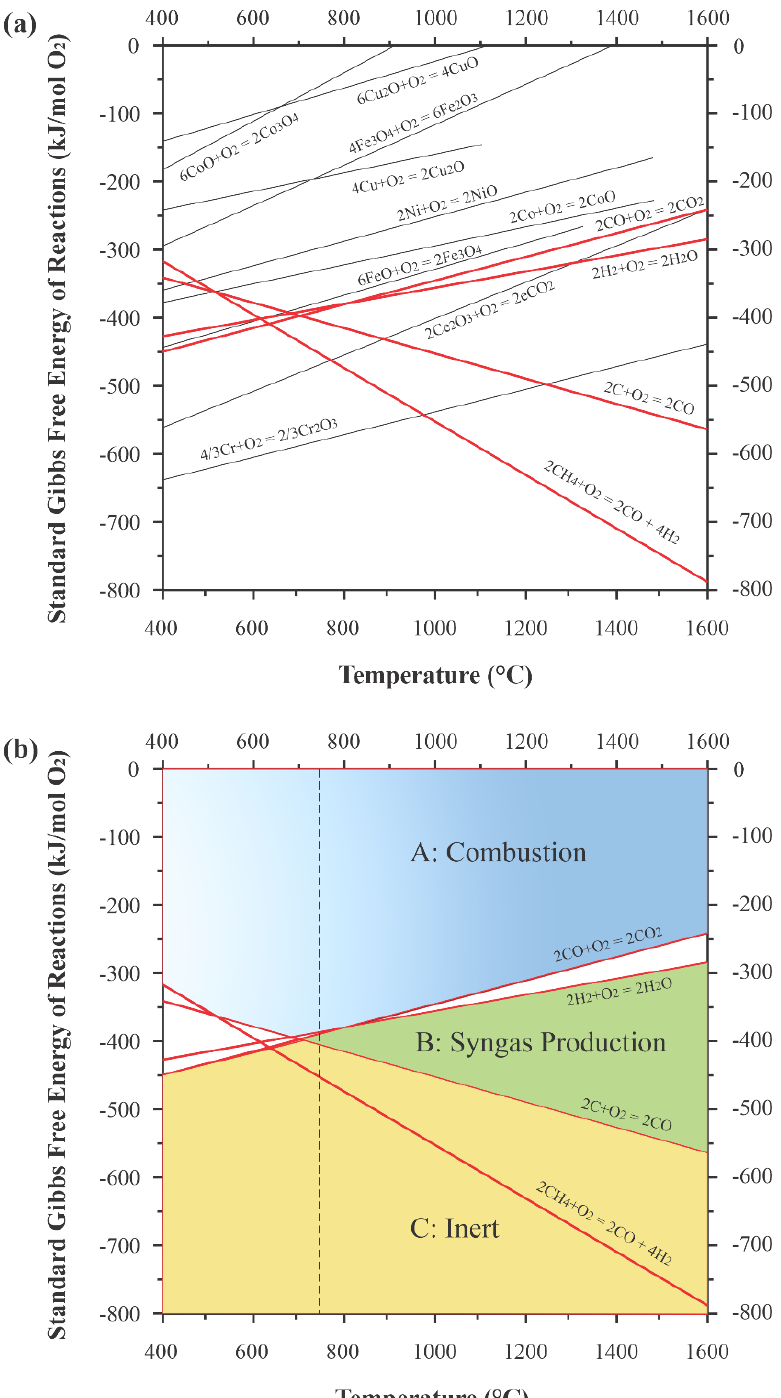
Figure 8. Modified Ellingham diagram for oxygen carrier material: ( a ) standard Gibbs free energy changes of some oxidation reactions and ( b ) reaction zones for syngas production applications [9] .